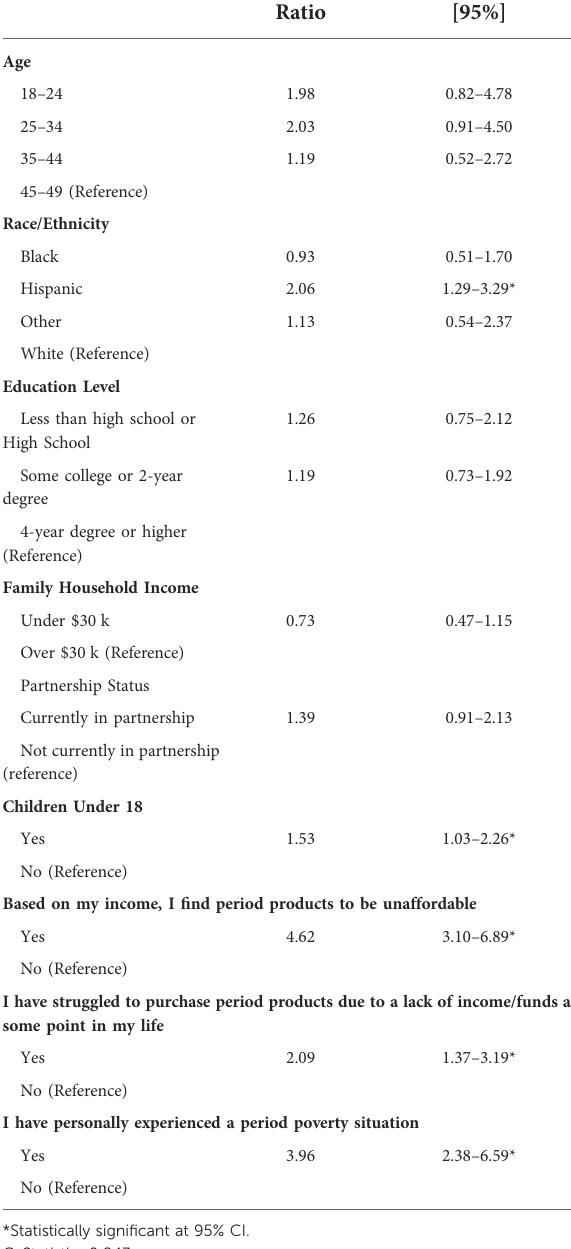
TABLE 3 Weighted logistic regression for predictors of the COVID-19 pandemic having made it more dif fi cult to access period products ( n =870).